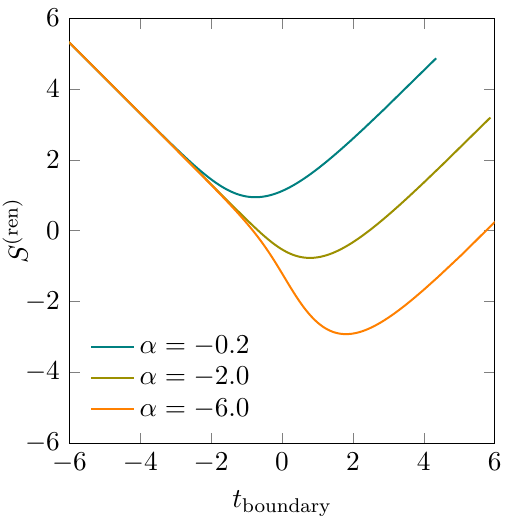
Figure 11 . Renormalized entropy S ( ren ) associated to extremal surfaces connecting to the brane as a function of the boundary time t boundary